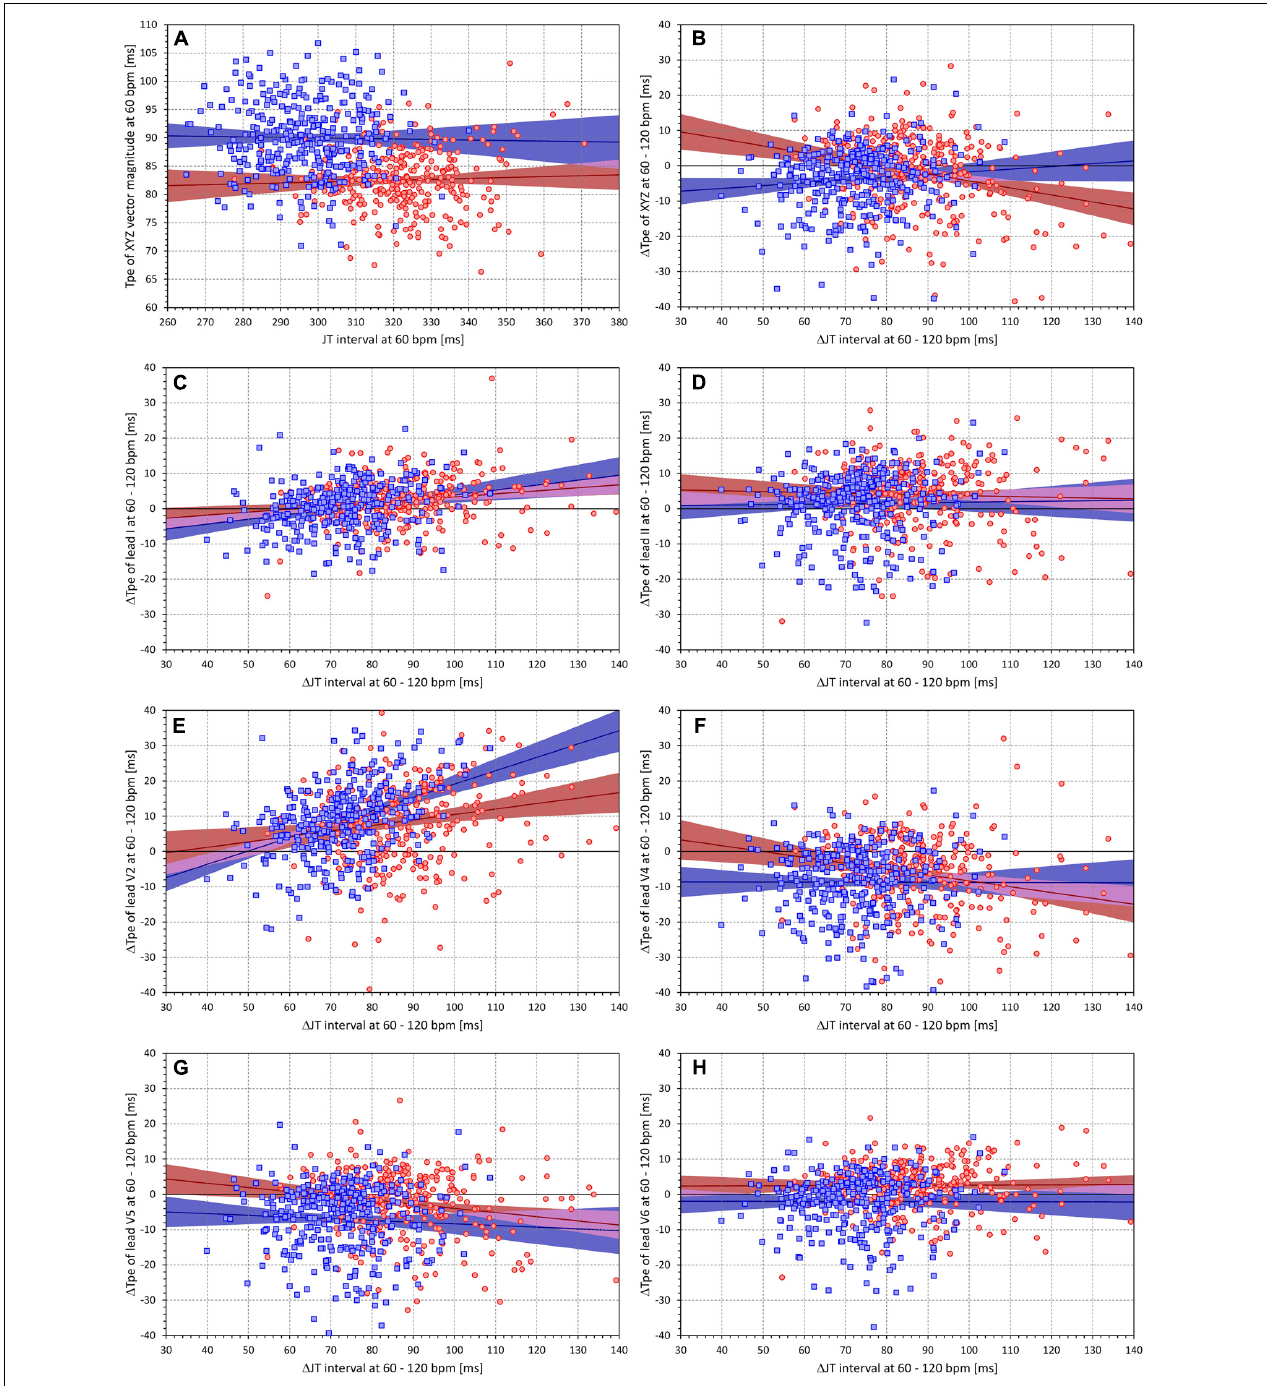
FIGURE 7 | (A) Scatter diagram between the subject-specific projections of JT intervals and Tpe intervals (measurement in the XYZ vector magnitude) to the heart rate of 60 bpm. (B–H) Scatter diagrams between subject-specific JT interval changes from 60 to 120 bpm and Tpe interval changes from 60 to 120 bpm; the panels correspond to the Tpe measurement in different electrocardiogram (ECG) leads in the same way as the panels of Figure 5 . In each panel, the red circles and blue squares correspond to female and male subjects, respectively. The solid red and solid blue lines show the linear regressions between the displayed values in female and male subjects, respectively. The red- and blue-shaded areas are the 95% confidence intervals of the regression lines; the violet areas are the overlaps between the confidence intervals of the sex-specific regressions.